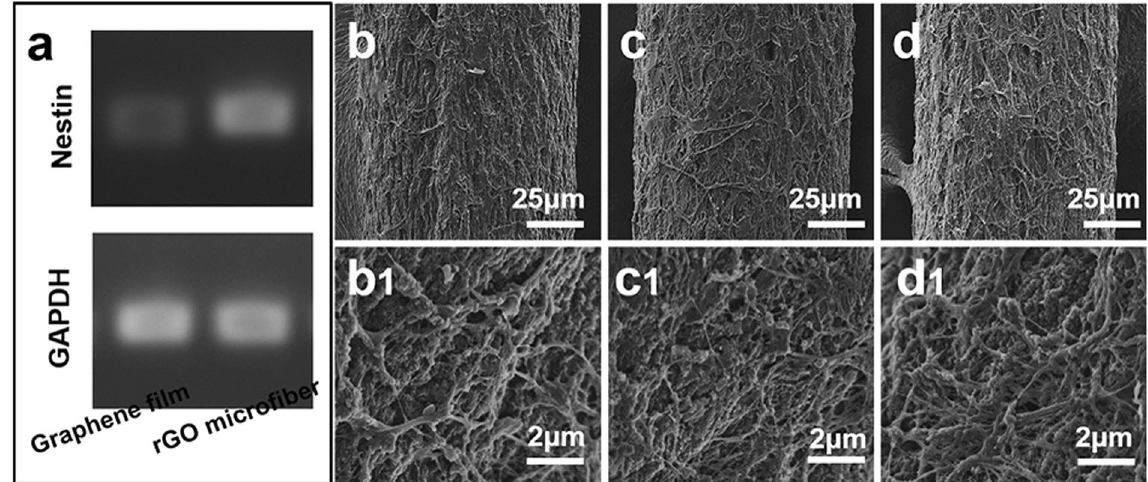
Figure 4. NSCs spreading on nanostructured rGO microfiber. ( a ) Nucleic acid electrophoresis analysis of Nestin expression on 2D graphene film and nanostructured rGO microfiber after 3 days culture. NSCs spreading on the nanostructured rGO microfiber, SEM images of the morphologies of NSCs cultured on nanostructured rGO microfibers for ( b ) 5, ( c ) 10 and ( d ) 15 days, and ( b1 ), ( c1 ), ( d1 ) are their high-resolution SEM images, respectively.